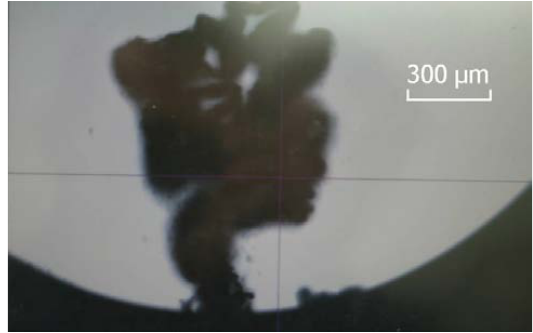
Figure 9. Continuous and ribbon-like chip.